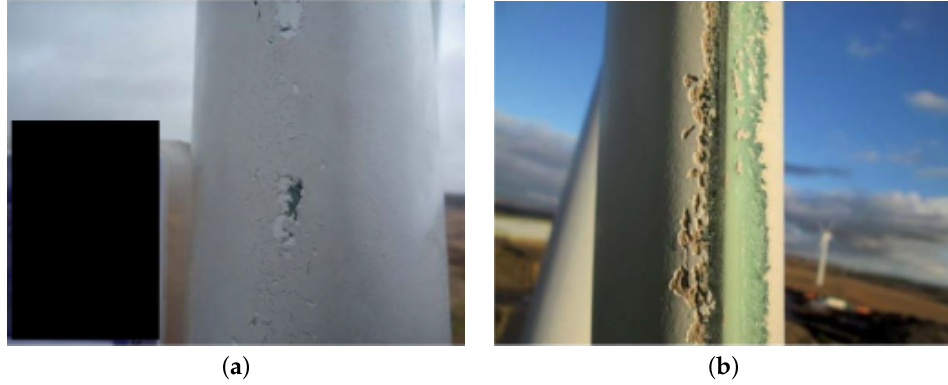
Figure 1. Minor ( a ) and major ( b ) erosion damage on the leading edge of wind turbine blades (reprinted from